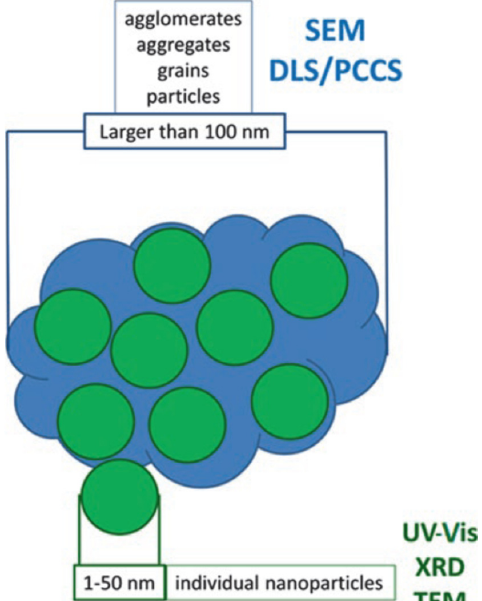
Figure 5. Schematic illustration showing which techniques report the size of individual nanoparticles of few nanometers and that of agglomerates/grains of size larger than 100 nm. Reprinted by permission from Springer Nature Customer Service Centre GmbH: Springer Nature [31], COPYRIGHT (2020).